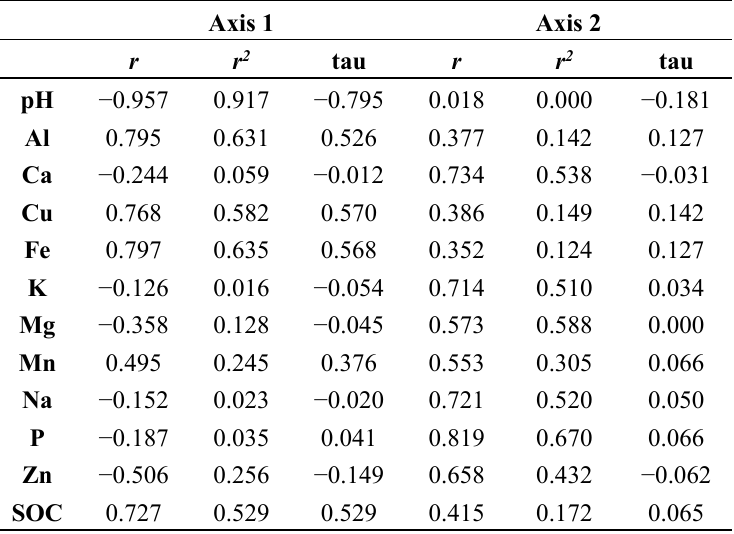
Table 4. Pearson and Kendall correlations with ordination